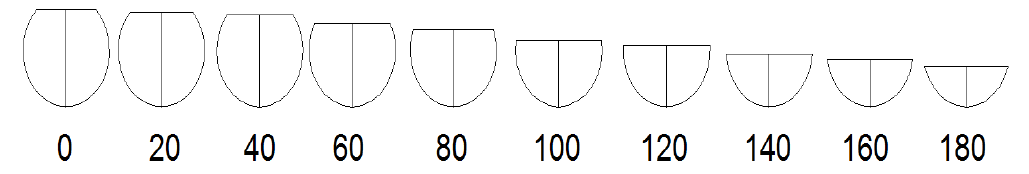
Figure 5. Method of measuring circumferences of injected grout.